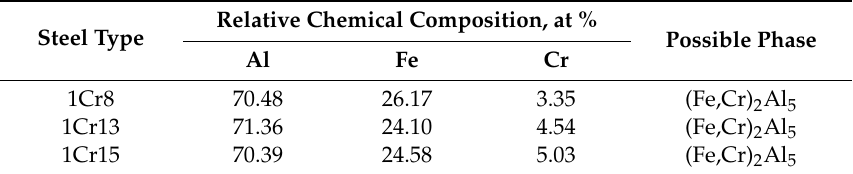
Table 2. EDS results of aluminide coatings formed on Al-deposited Cr steel substrates after 500 ◦ C, 4 h heat treatment in